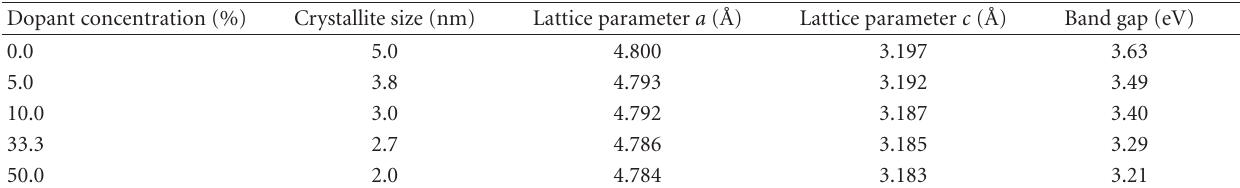
Table 1: Variation of particle size, lattice parameter and band gap with dopant concentration.